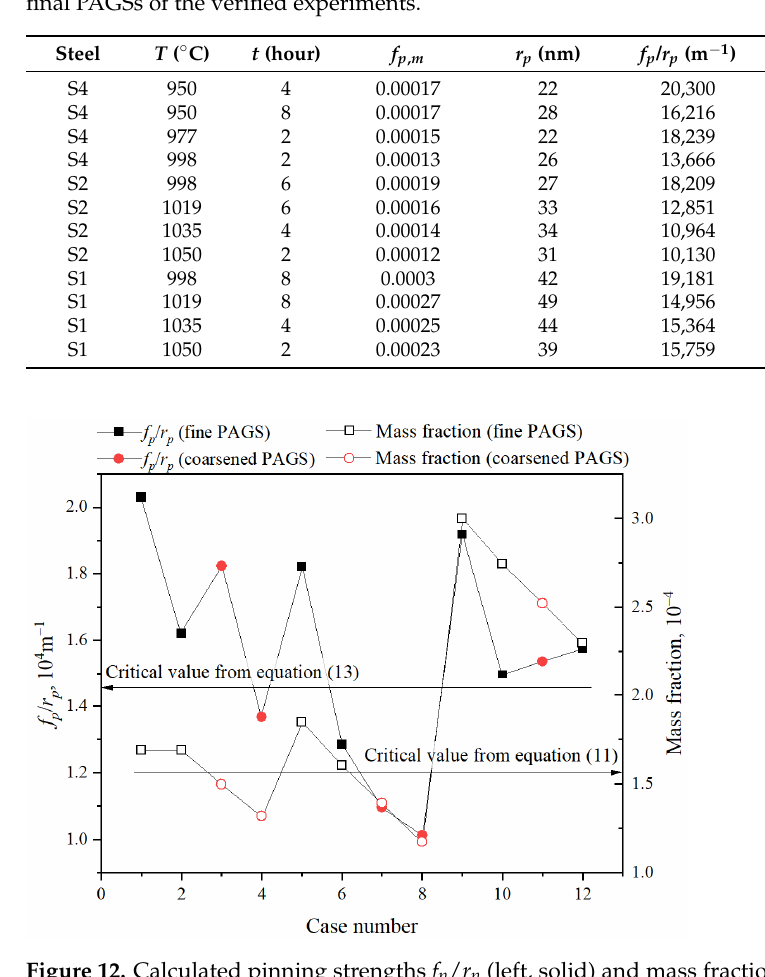
Figure 13. Several PAGSs of the verified experiments. Using the models, we can propound the suggestion of composition modification for similar steel grades. For instance, a steel plant in China has suffered surface cracking in the continuous casting of 20Cr for a long time. The main composition of this steel is similar to the one in Table 1 and the contents of Al and N are listed in Table 5. The variation ranges of these elements allowed by the user are provided as well. It is noticed that the N content in this steel is rather high. Since the practical carburizing schedule of this steel is holding for 4 h at 960 °C, we choose Equation (11) to optimize the Al and N contents. According to the calculation of Thermo-Calc, the mass fraction of AlN at 960 °C associated with different Al and N contents is shown in Figure 14. As indicated, the AlN mass